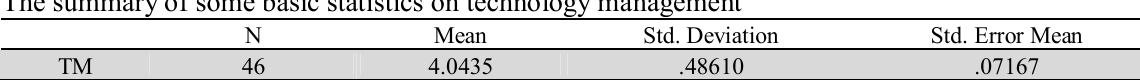
The summary of some basic statistics on technology management